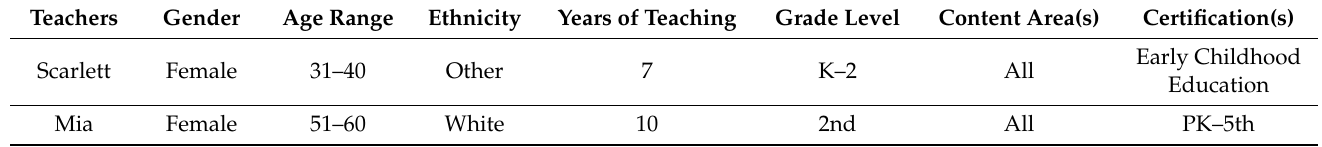
Table 1. Participants’ demographic